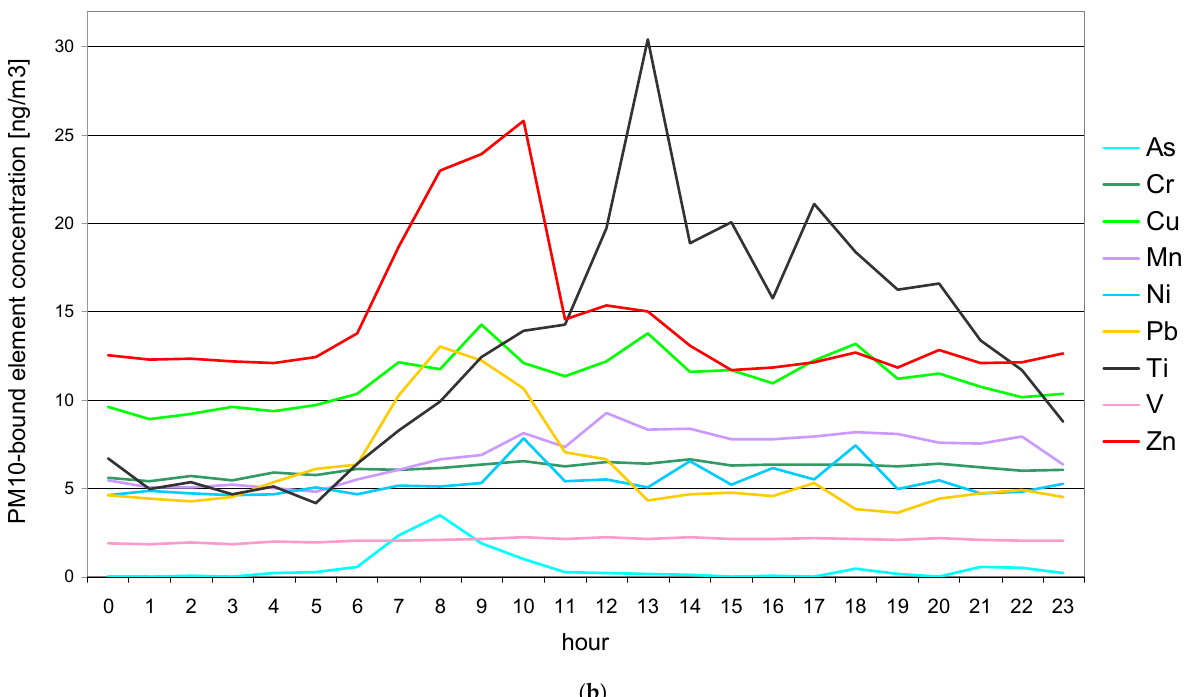
Figure 3. The average hourly concentrations of ( a ) Al, Ca, Fe, S, Si and K, and ( b ) As, Cr, Cu, Mn, Ni, Pb, Ti, V and Zn, averaged for the entire measurement period (03–31.07.2019), as measured by the receptor.